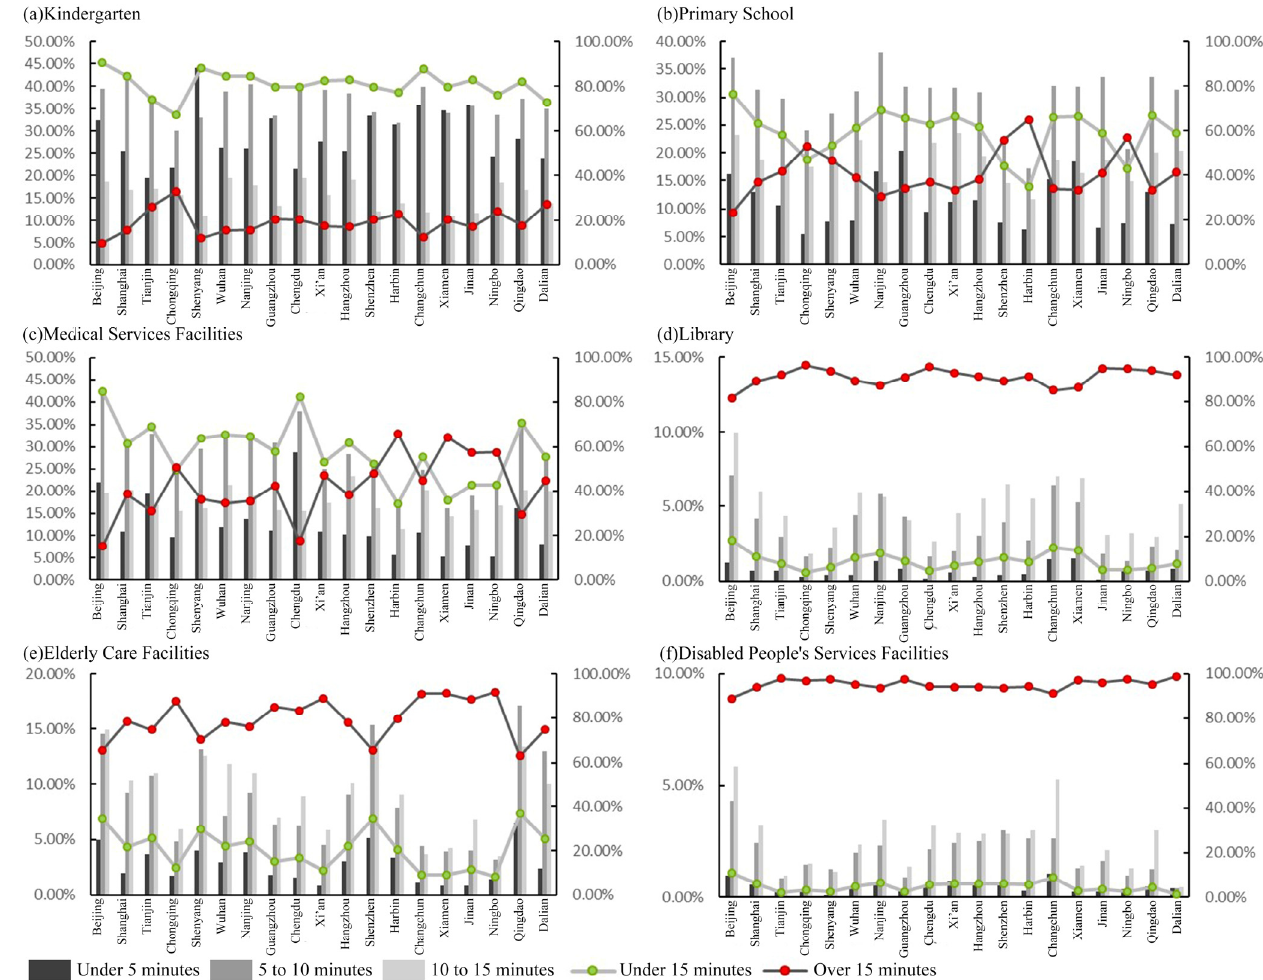
Figure 5. Statistical results of the accessibility circle of basic public service facilities. ( a ) Statistical results of the accessibility circle of Kindergarten. ( b ) Statistical results of the accessibility circle of Primary School. ( c ) Statistical results of the accessibility circle of Medical Services Facilities. ( d ) Statistical results of the accessibility circle of Library. ( e ) Statistical results of the accessibility circle of Elderly Care Facilities. ( f ) Statistical results of the accessibility circle of Disabled People’s Services Facilities.